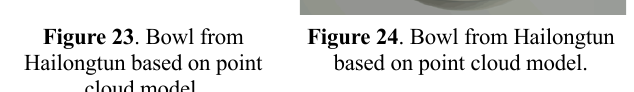
Figure 23 . Bowl from Figure 24 . Bowl from Hailongtun Hailongtun based on point based on point cloud cloud model.